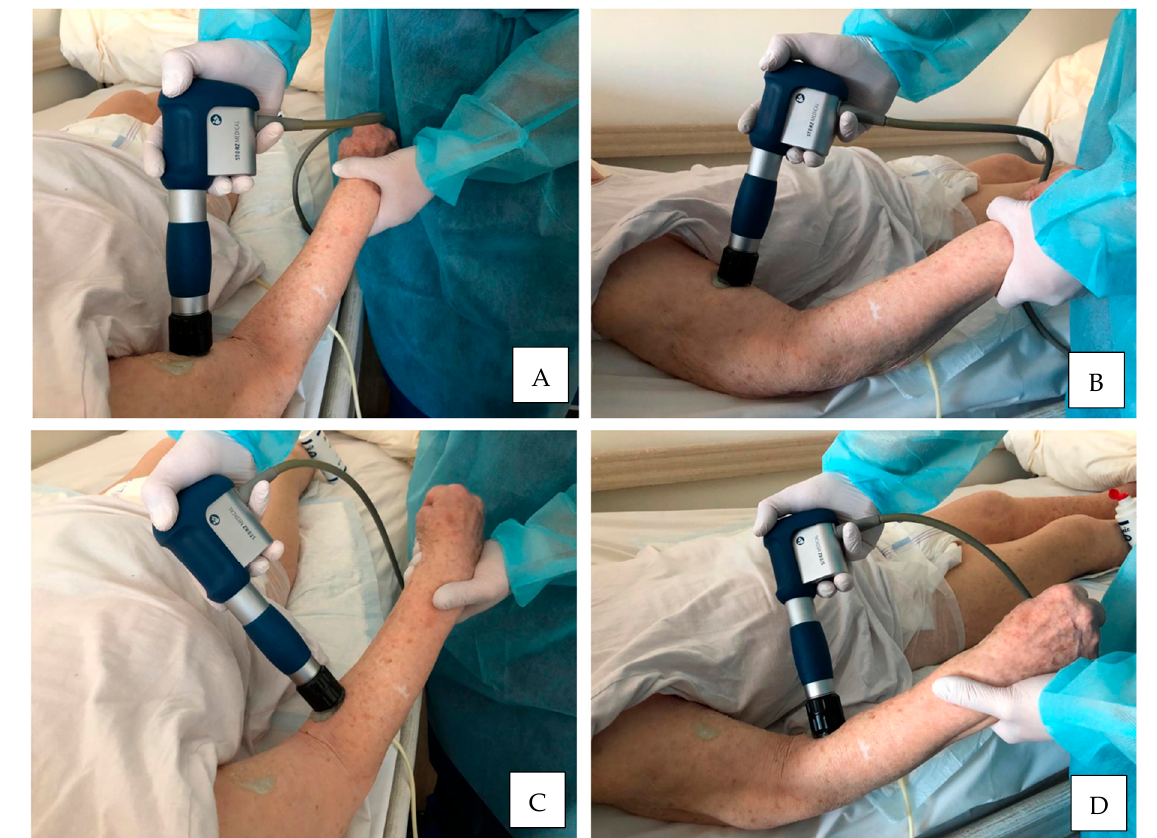
Figure 2. An exemplary methodology of rSWT application for the upper limb muscles. ( A , B ), treatment session delivered to the elbow flexors; ( C , D ), treatment session delivered to the wrist flexors.